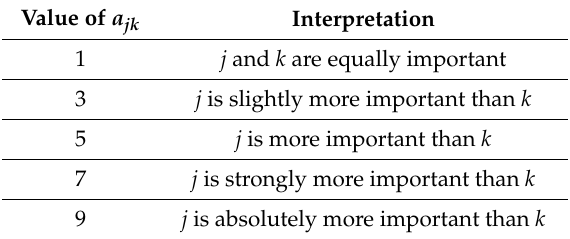
Table 1. Table of relative